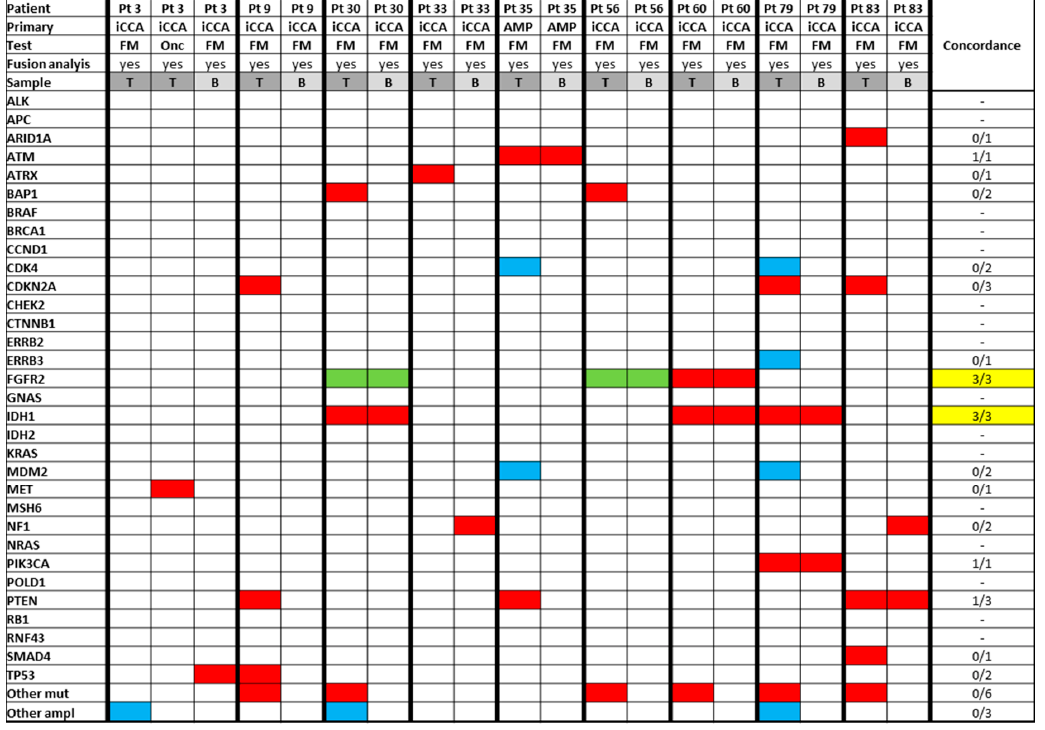
Figure 4. Paired tissue and ctDNA samples. iCCA: intrahepatic cholangiocarcinoma; eCCA: extrahepatic cholangiocarcinoma; GBC: gallbladder cancer; Amp: ampulla of Vater carcinoma; FM: Foundation Medicine ® , refers to FoundationOne CDx ® or FoundationOne Liquid ® panel; Onc: Oncomine ® panel; B: blood (ctDNA); T: tumour tissue; %: percentage; Pt: patients ID. Red box: mutation; blue box: amplification; green box: fusion; and yellow box: targetable alteration.